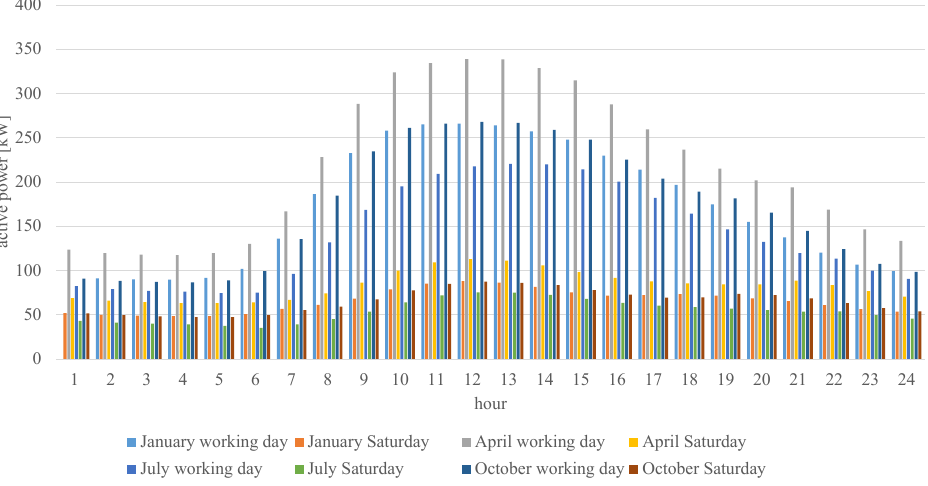
Figure 7. The assumed B23 profile based on the measurement and standard profiles from the distribution network operator and maintenance manual and contracted power.